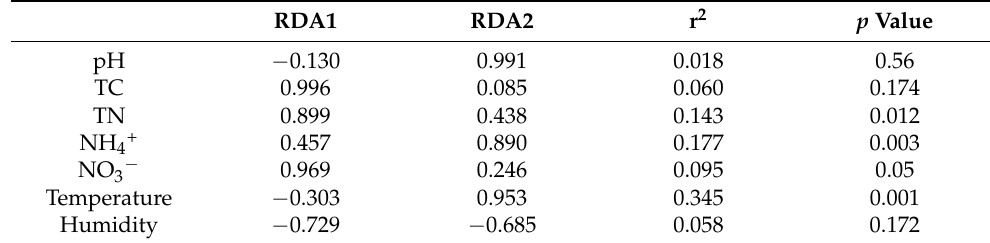
Figure 3. RDA ordination diagram of environmental factors in relation to soil samples. Environmental factors are indicated by lines with arrows, and the soil samples are represented by dots. Table 1. Correlation coefficients, r-squared and significance values for environmental factors with RDA